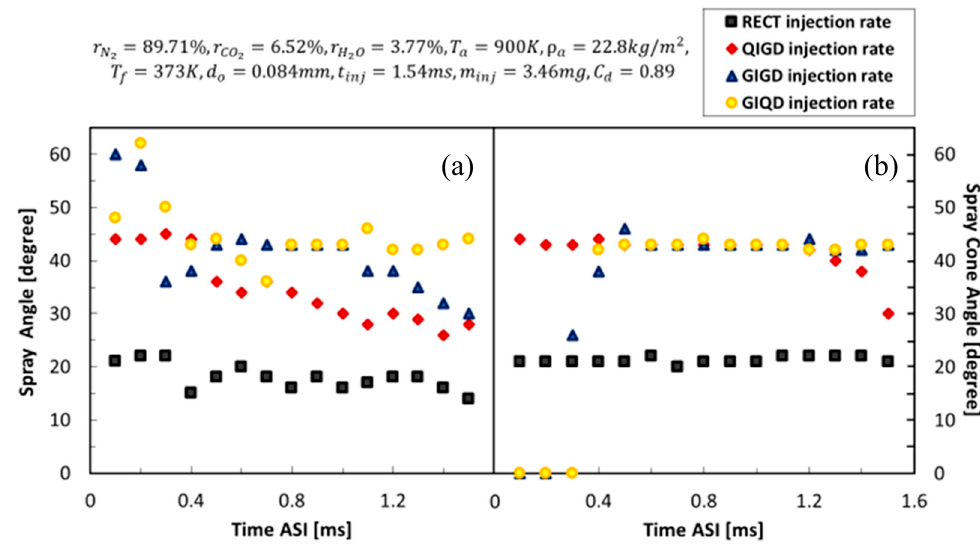
Figure 15. Comparison of the spray distribution angle for different injection rate shapes. ( a ) Spray angle and ( b ) spray cone angle.